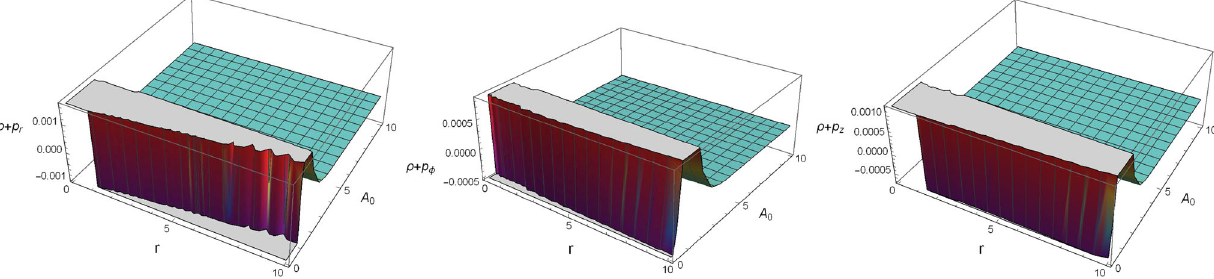
Fig. 30 This panel shows the variation of (ρ + p r ) (MeV/fm 3 ) , (ρ + p φ ) (MeV/fm 3 ) and (ρ + p z ) (MeV/fm 3 ) w.r.t r (km) with m = − 3 and n = 2. One can clearly sees that NEC is valid at some particular values of the radial coordinate.)